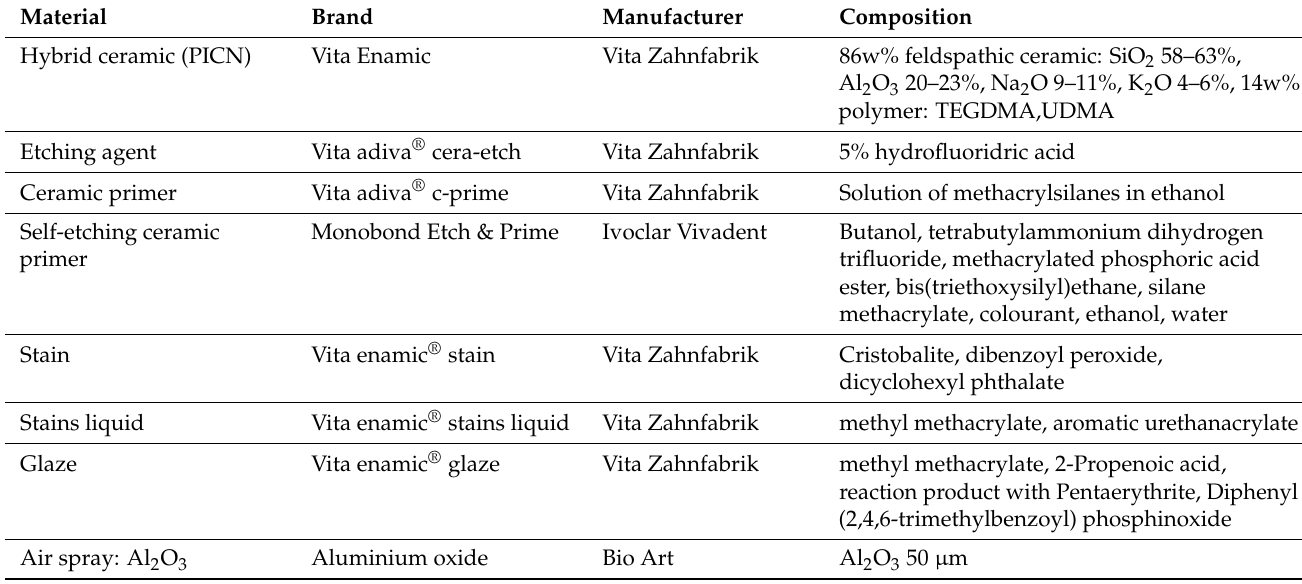
Table 1. Materials, brands, manufacturers, and chemical compositions of the materials used in the